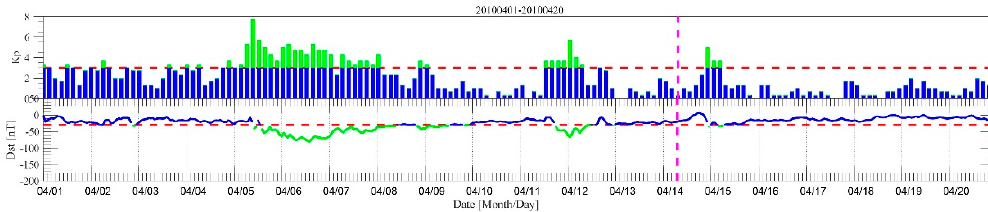
Figure 4. The Kp and Dst index during 1–20 April; the green histogram and curve indicate high geomagnetic activities and space weather activities and the pink dashed line denotes the original time of the Yushu earthquake.